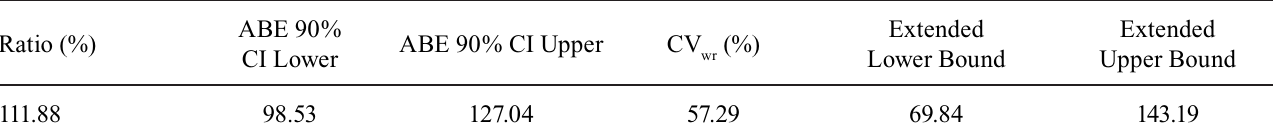
TABLE V - Ratio between geometric means, confidence intervals, reference coefficient of variation and extension of the acceptance limits for phenylephrine in parameter Cmax